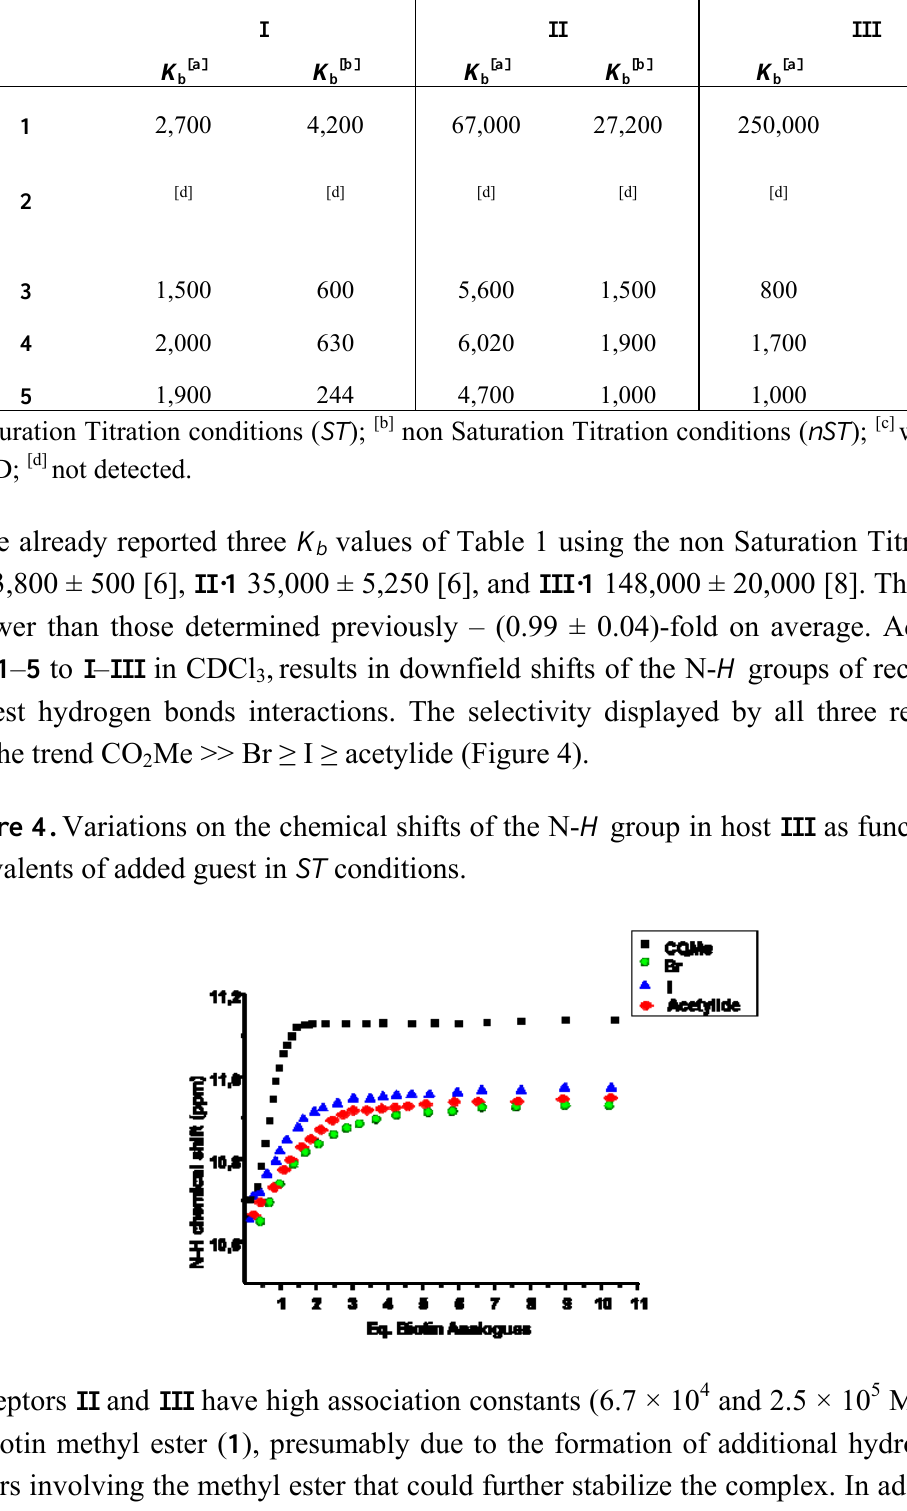
Table 1. Association constants K (Errors ≤ 10%).